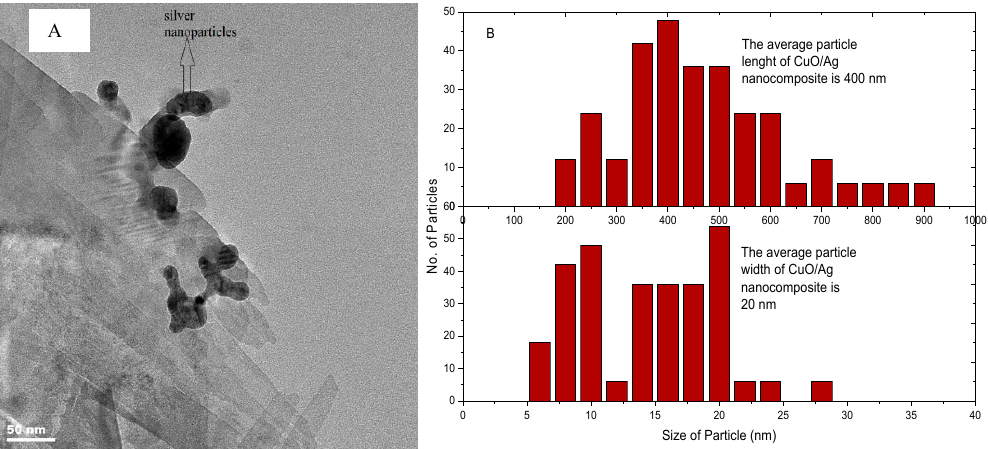
Figure 4. ( A ) Transmission electron microscope (TEM) micrograph of CuO / Ag and ( B ) particle size distribution of CuO / Ag nanocomposite, adapted from reference [19].